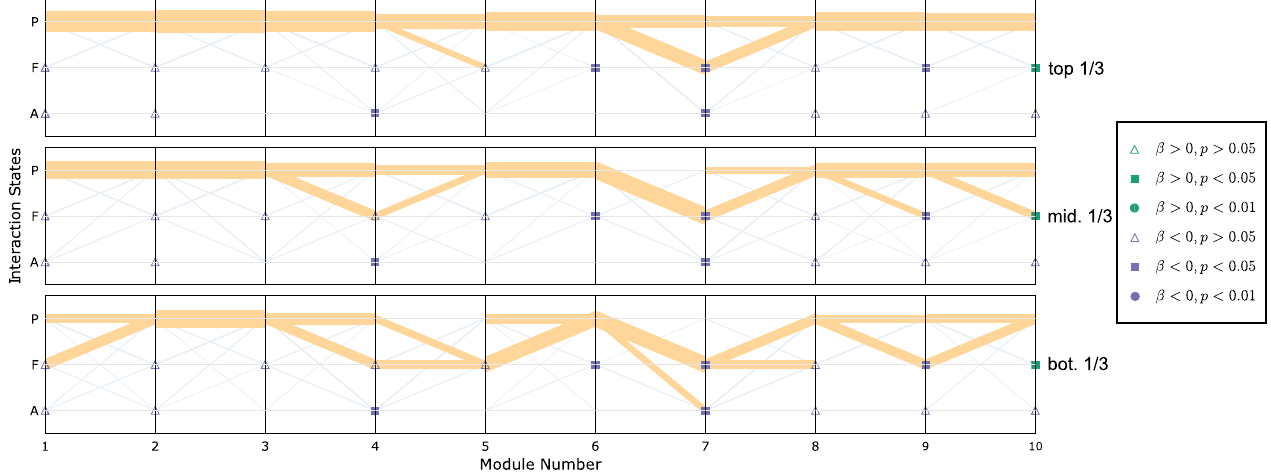
FIG. 3. Parallel coordinate graphs using level I (three) states.